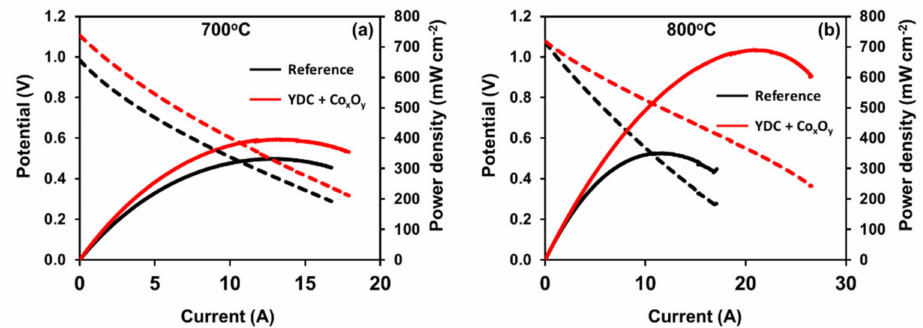
Figure 4. I–V curves and power densities of infiltrated and reference cells measured at ( a ) 700 ◦ C and ( b ) 800 ◦ C.